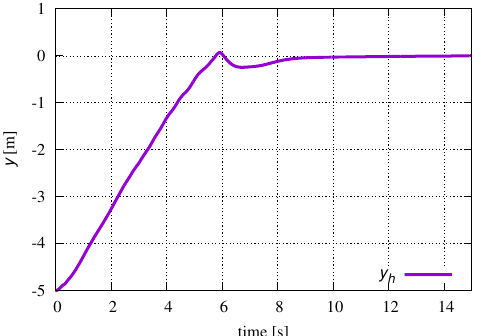
Figure 6. Case 1: Time variation of the y coordinate of the head position.